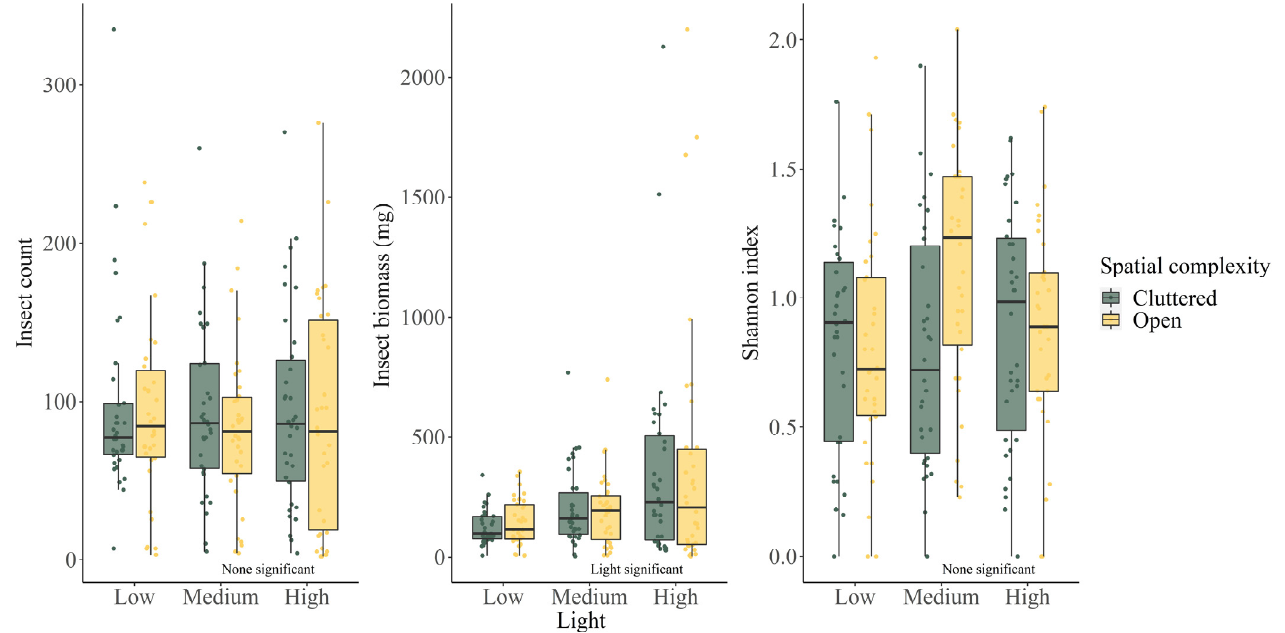
Figure 1. Boxplots (25th, 50th, 75th percentiles) and raw data points of insect count, Shannon diversity index, insect biomass at sites of varying ALAN levels, and spatial complexity. Independent variable significance is annotated in the graph. Table 2. General linear models results (regression estimate ± standard error on top, p value at bottom, n = 204) on species-specific bat activity in relation to ALAN, spatial complexity, and